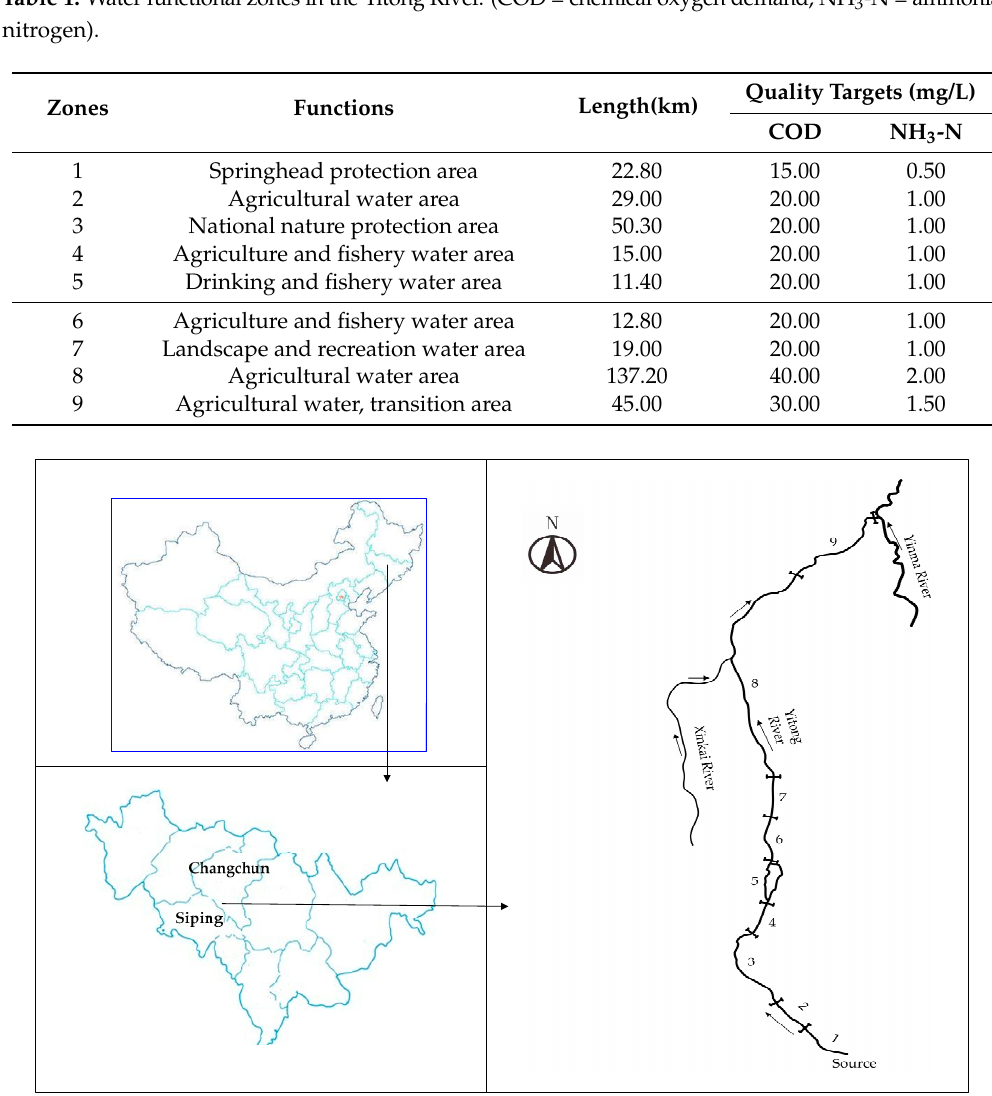
Figure 1. The geographical position and function zones of the Yitong River. Table 1. Water functional zones in the Yitong River. (COD = chemical oxygen demand, NH 3 -N = ammonia nitrogen).